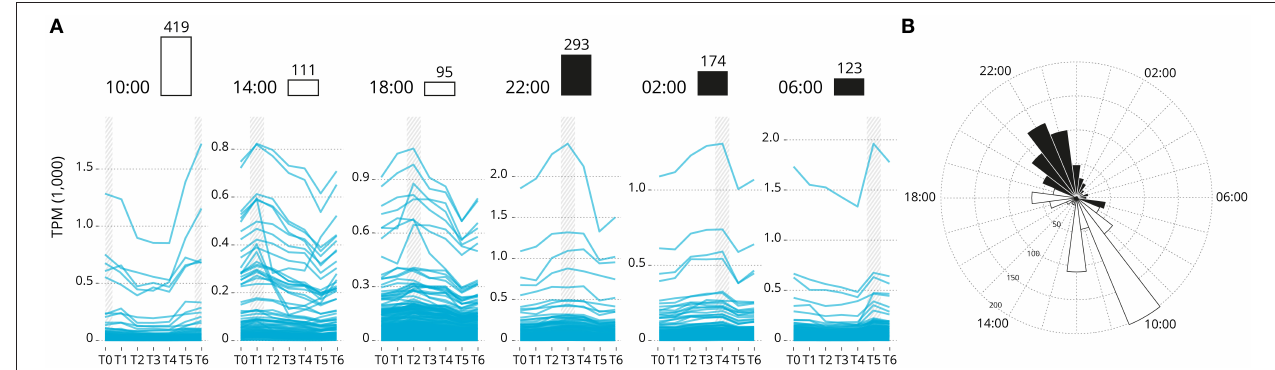
FIGURE 3 | Genes groups based on their acrophase (expression peak) synchronicity. (A) Based on the average recorded TPM values. The number of gene is reported over the barplot (white and black boxes denote light or darkness conditions, respectively). Sub-figures exclude three highly expressed genes that bias the scale of the graphic: Ependymin-1 ( > 10,000 TPM) Ependymin-2 ( > 5,000 TPM) and calcium voltage-gated channel auxiliary subunit alpha 2 delta 4 ( > 2,000 TPM). (B) Rose plot of the phase distribution of highly significantly circadian gene expression ( p < 0.001, JTK analysis). Color coding indicates whether the phase occurs during the light (white) or dark (black) (12:12